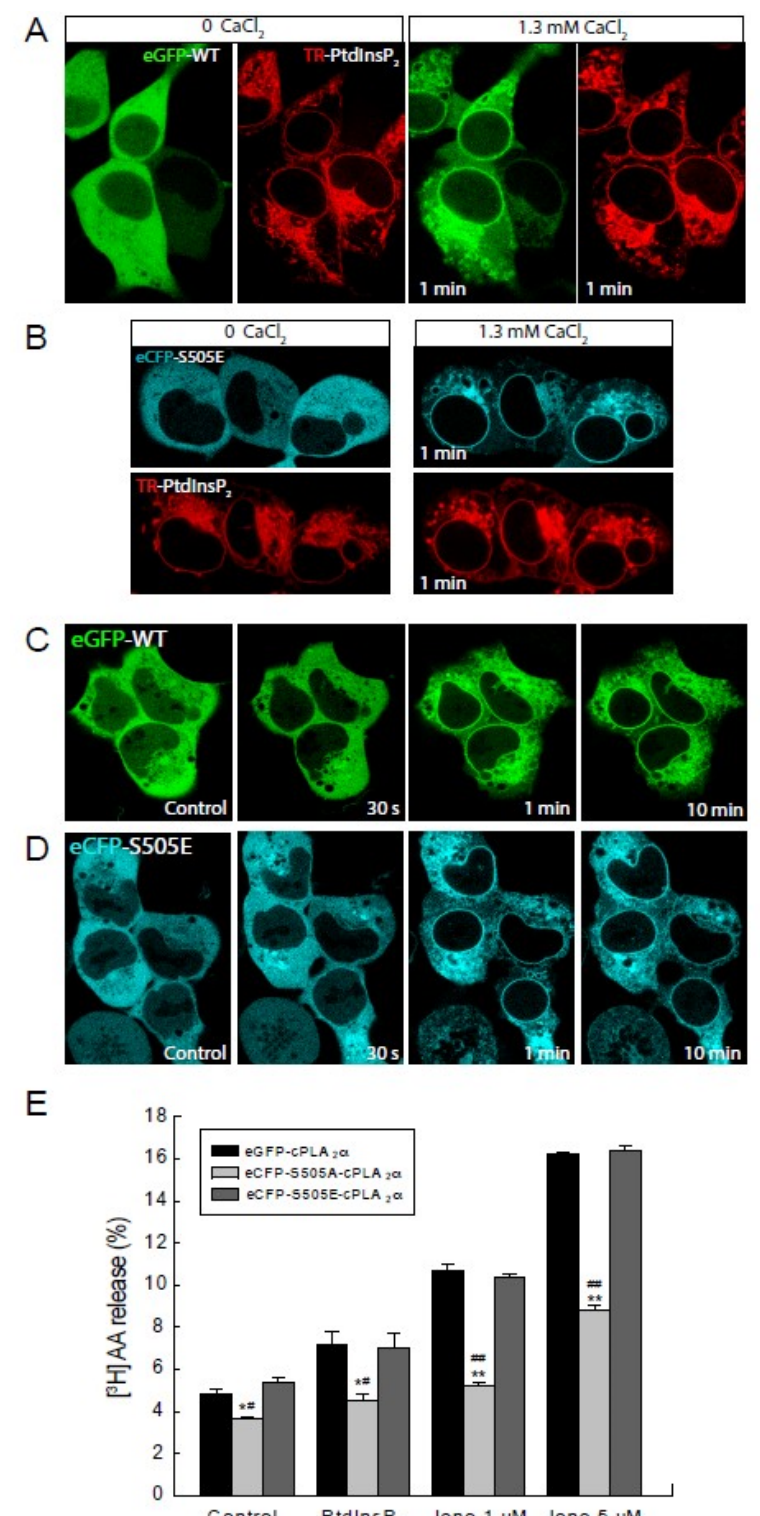
Figure 4. Translocation capabilities and cellular activity of the mutant eCFP-S505E-cPLA 2 α . HEK cells stably transfected with eGFP-cPLA 2 α ( A , C ) or the mutant eCFP-S505E-cPLA 2 α ( B , D ) were incubated with TR-PtdInsP 2 /histone in the absence of extracellular Ca 2+ (labeled as 0 CaCl 2 ) for 10 min ( A , B ). Afterward, 1.3 mM CaCl 2 was added to the medium to restore extracellular Ca 2+ levels (labeled as 1.3 mM CaCl 2 ) ( A , B ). In ( C , D ) HEK cells were stimulation with 5 µ M ionomycin for indicated periods of time. Pictures were taken to live cells under the confocal microscope at the indicated time points. ( E ) Cells stably transfected with the construct eGFP-cPLA 2 α (black bars),